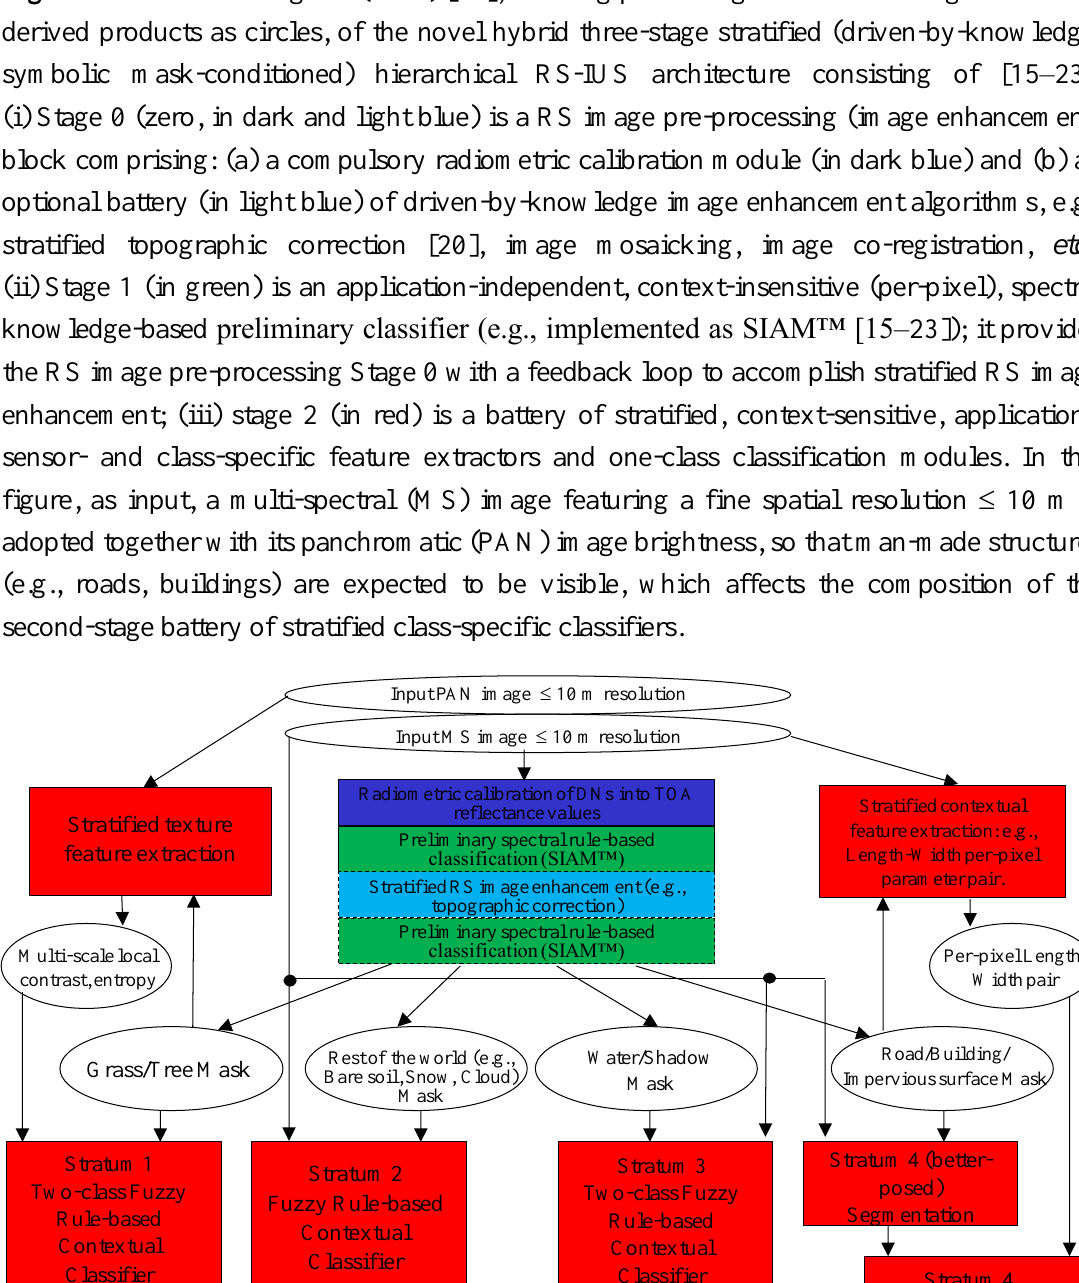
Figure 2. Data flow diagram (DFD) [40], showing processing blocks as rectangles and